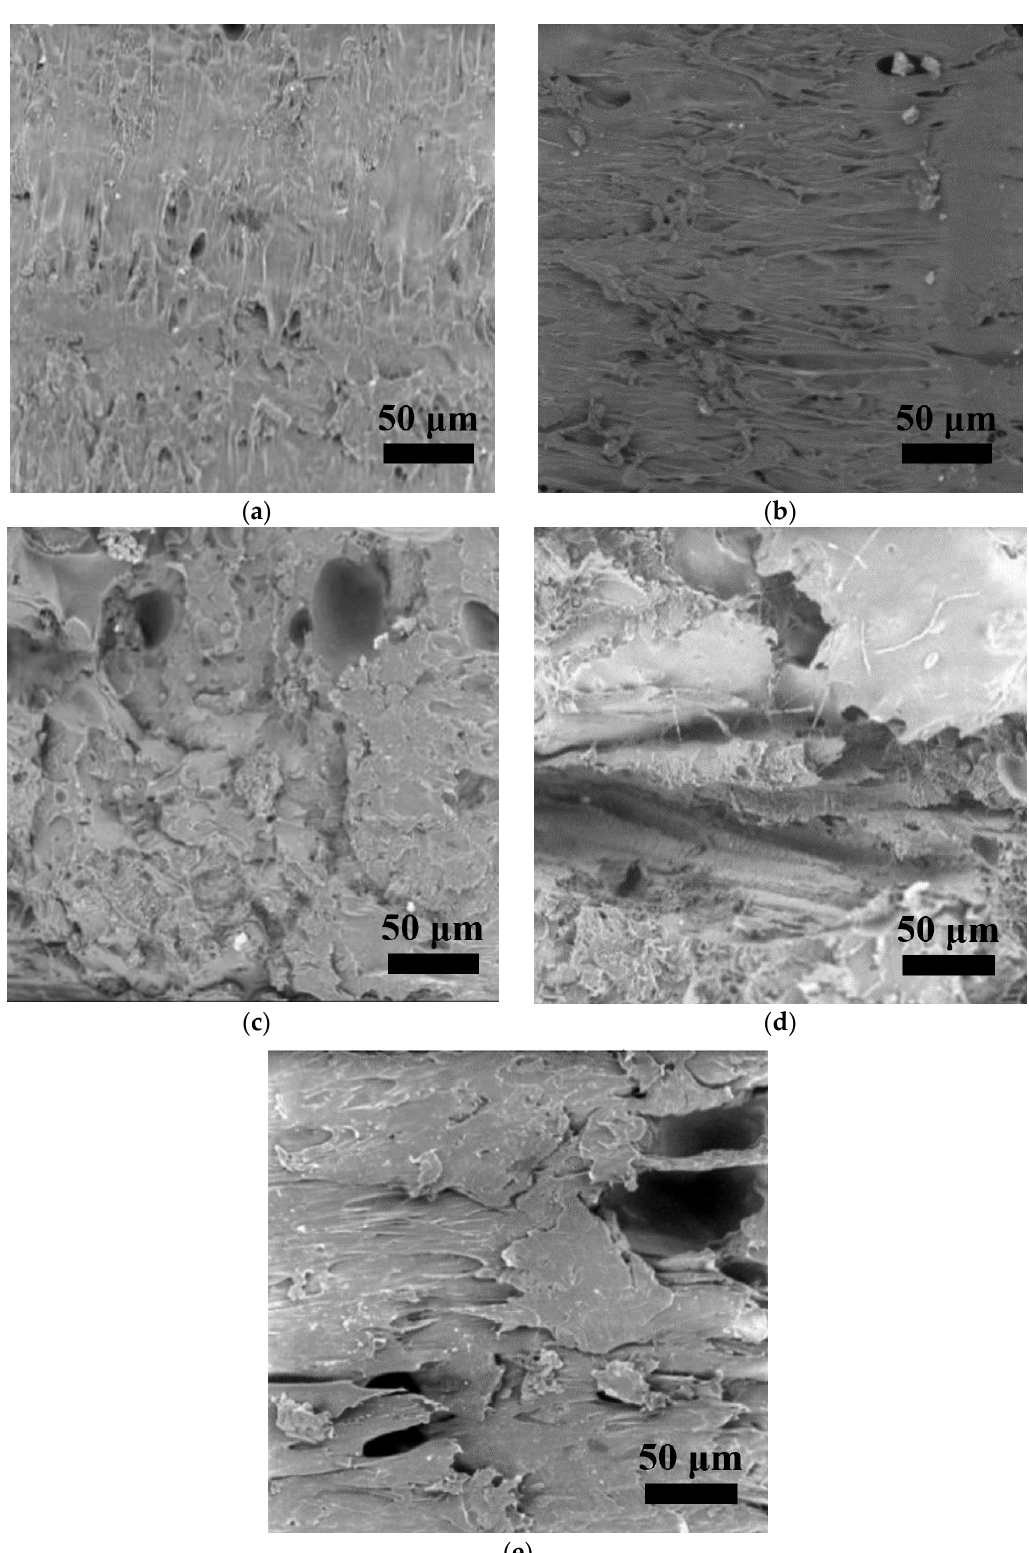
Figure 7. Cross-section morphology of PLA at different soil burial days: ( a ) 0; ( b ) 30; ( c ) 60; ( d ) 90; ( e ) 180.